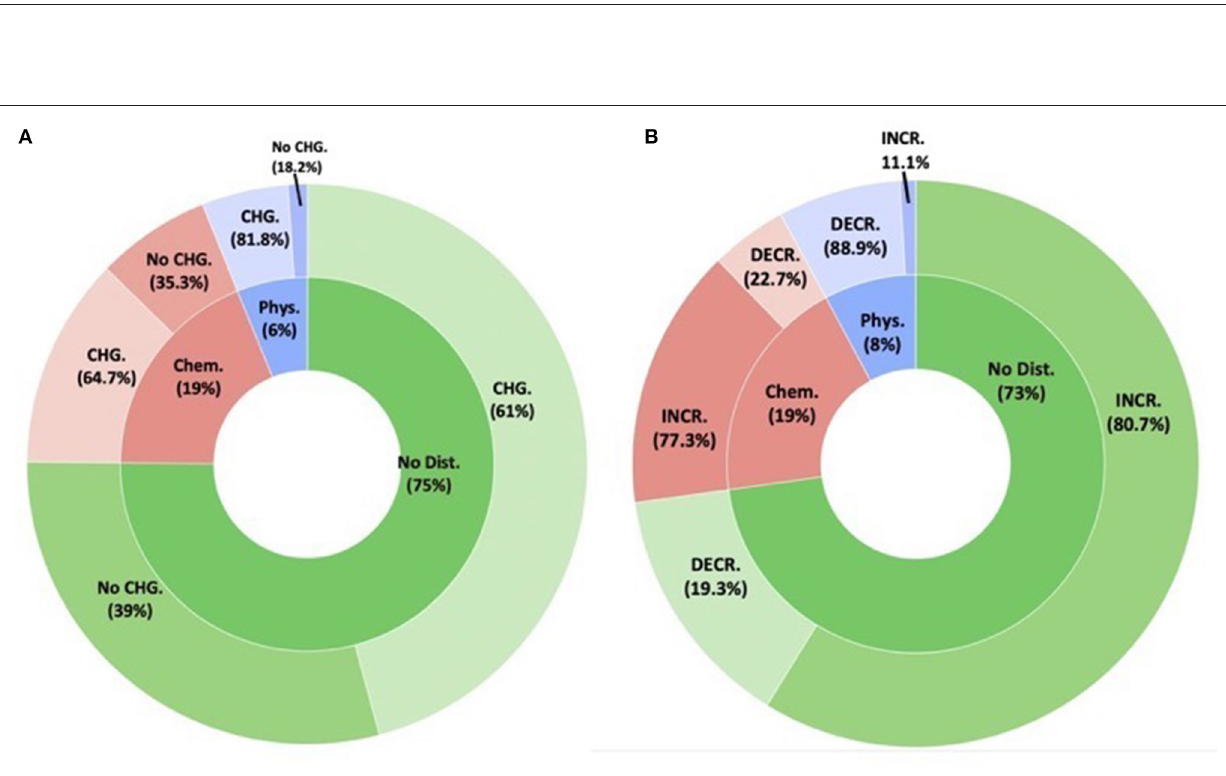
Frontiers in Agronomy |